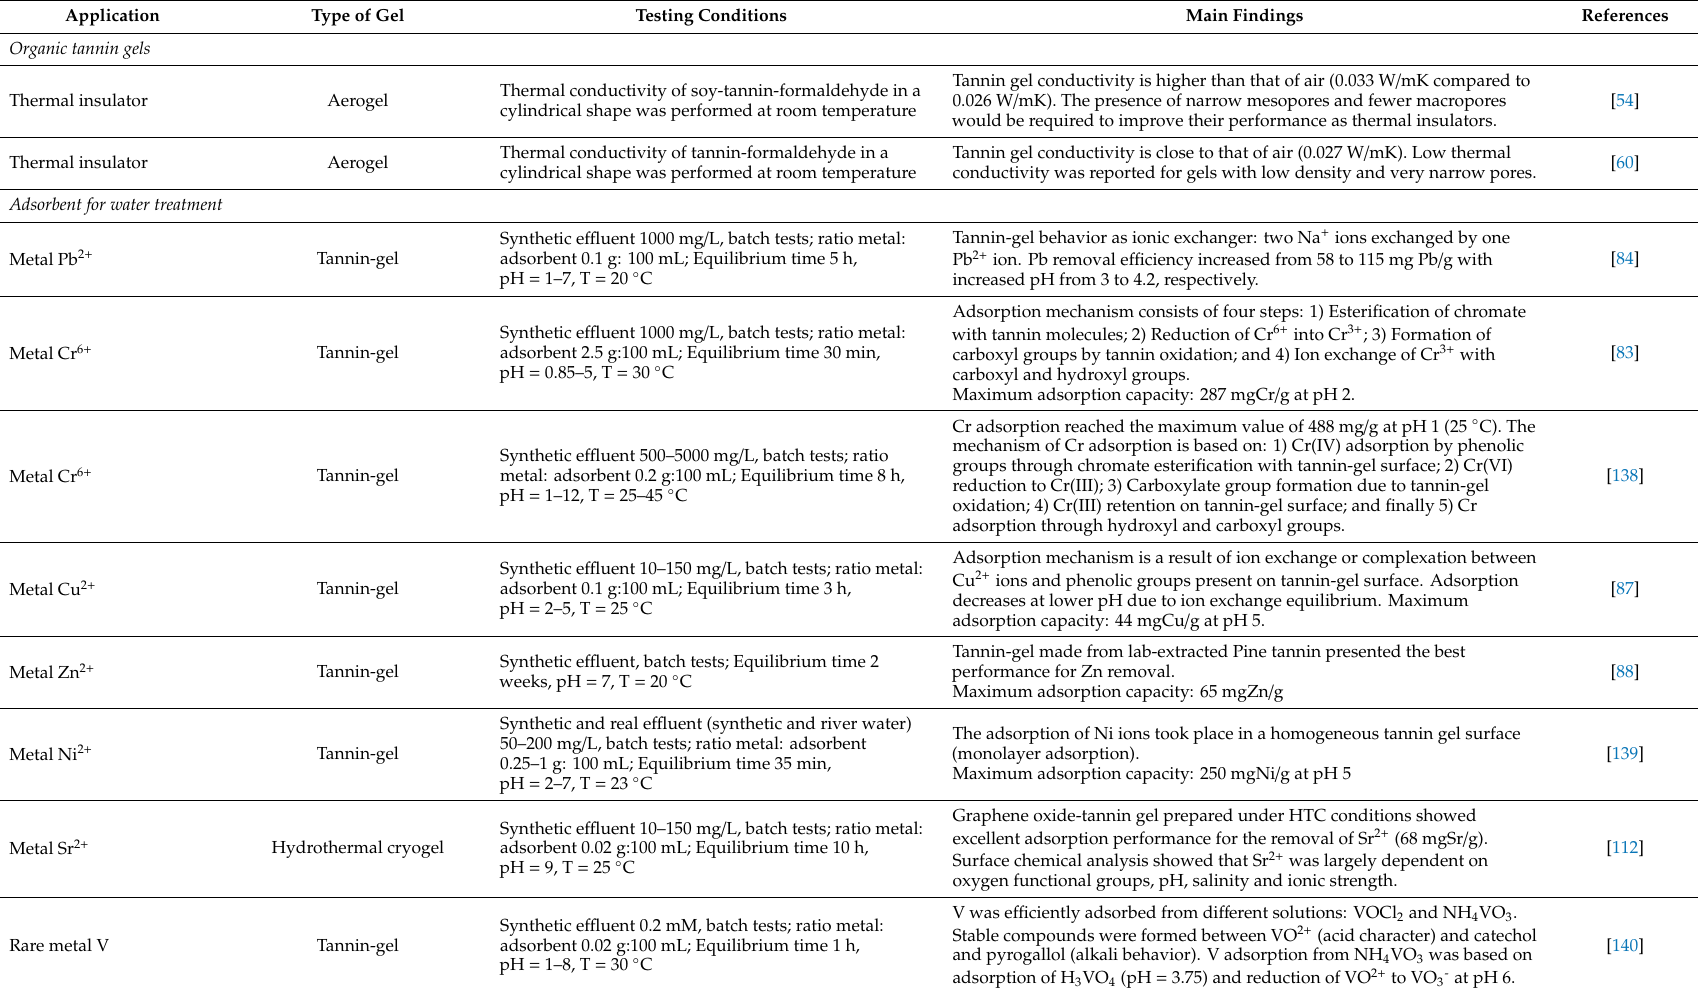
Table 3. Applications of organic and carbon gels made from